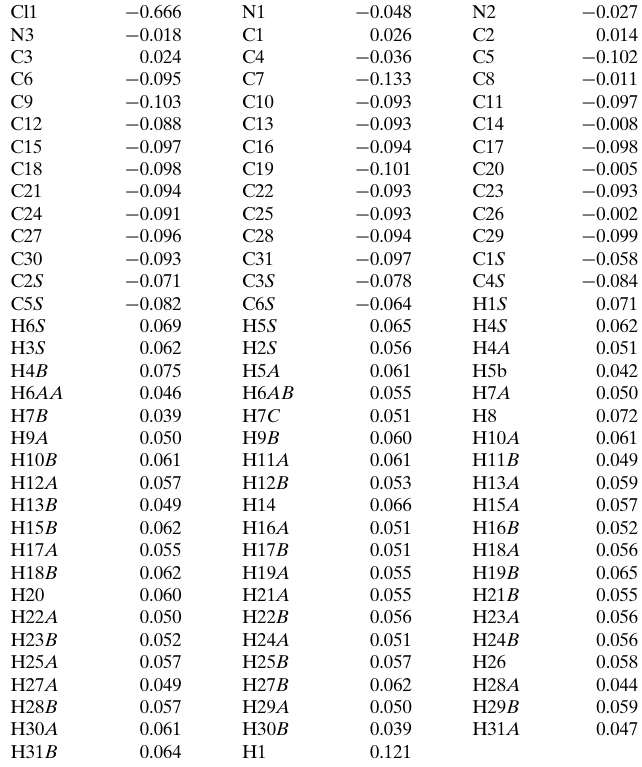
Table 3 Hirshfeld charges of atoms in [ 1 H]Cl (cid:2) C 6 H 6